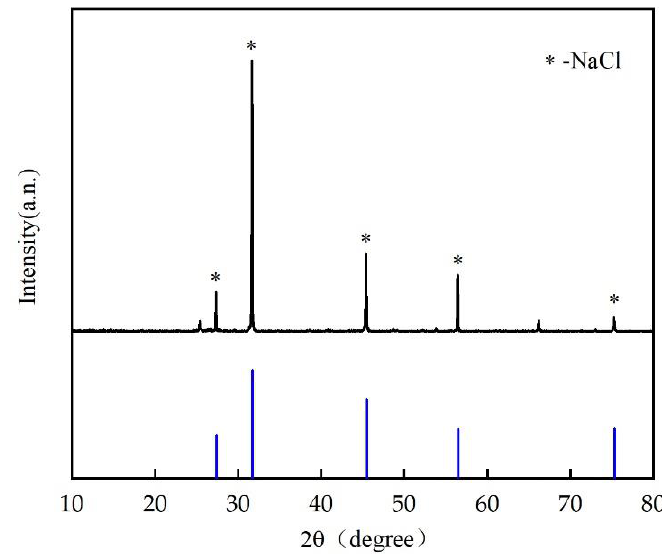
Figure 7. X-ray diffraction pattern of crystals in the salt-drying box. Table 5. Crystal composition analysis.